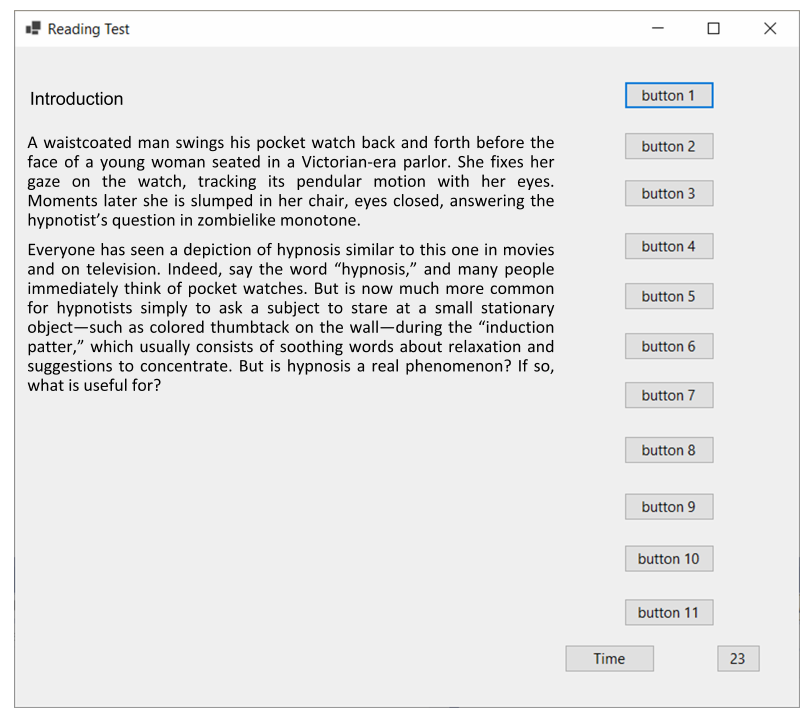
Figure 2. GUI of Full Screen